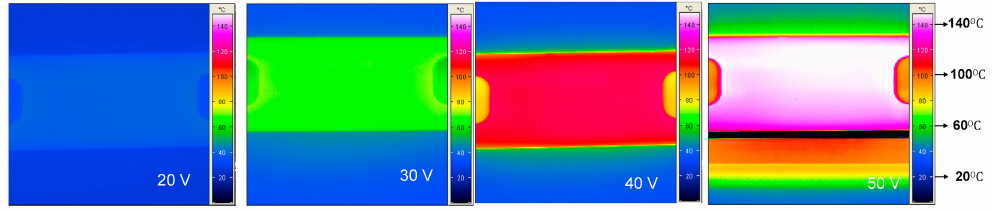
Figure 5. Thermal characterization of the preconcentrator heater at 20 V, 30 V, 40 V and 50 V,